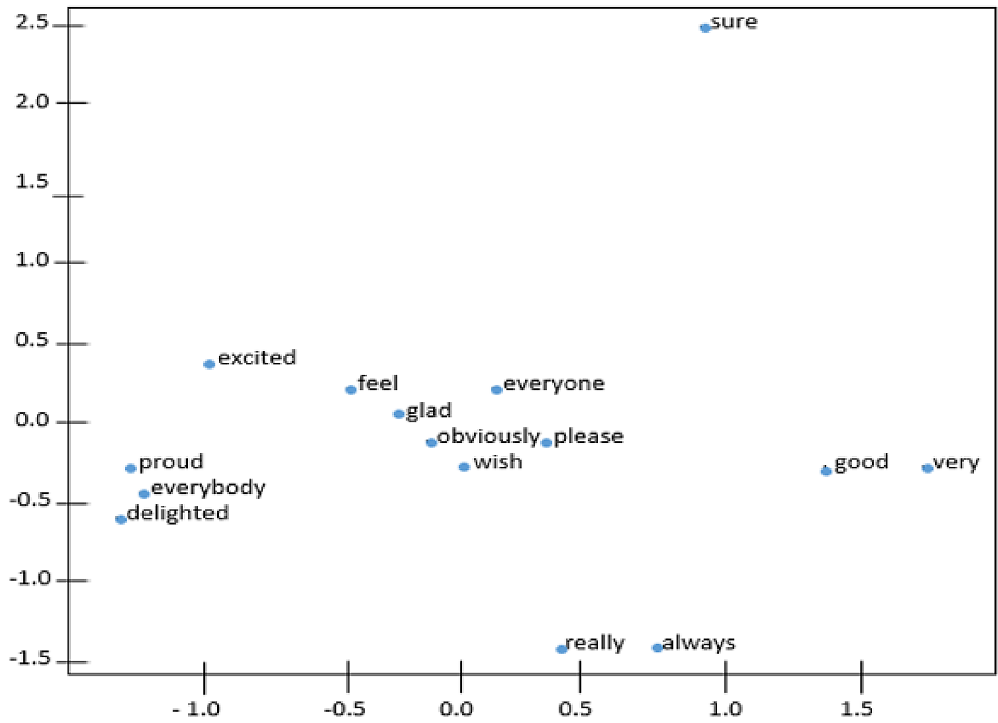
Figure 4. t-SNE plots of ‘ happy ’ on the